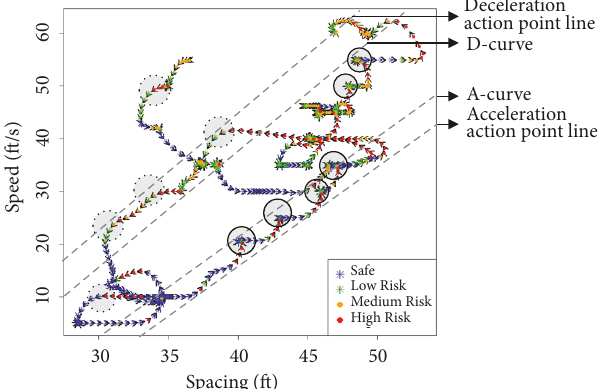
Figure 11: Collision risk estimated with the temporal spacing and speed